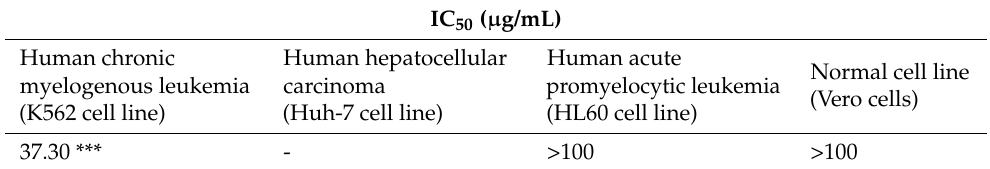
Table 3. Cytotoxicity of C. europaea lipids.